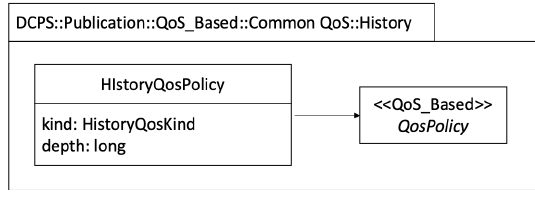
Figure 8. History